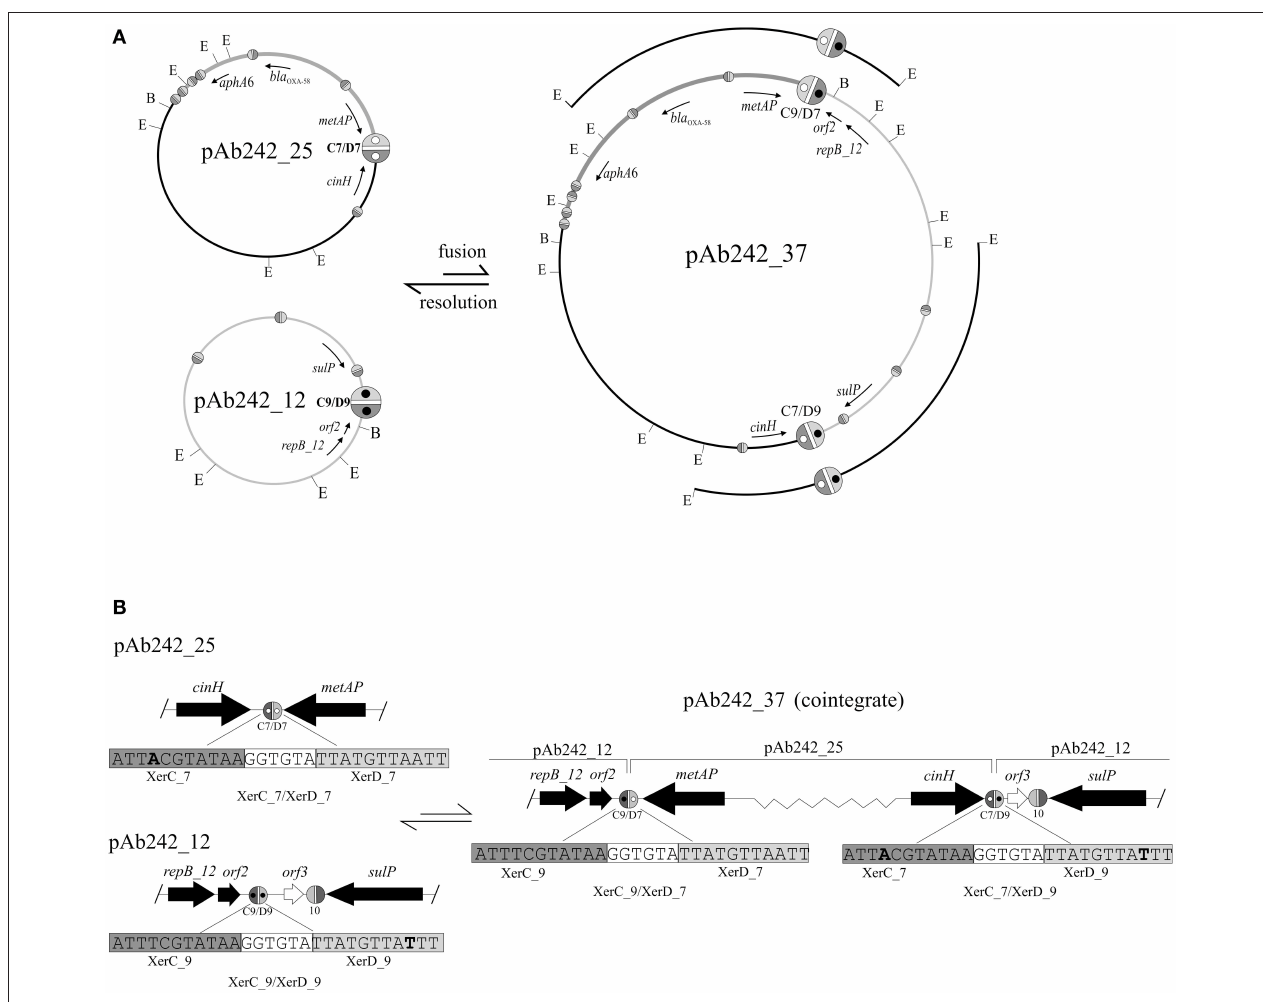
FIGURE 3 | Site-specific recombination between XerC/D sites mediates fusion between pAb242_25 and pAb242_12. ( A , Upper panel) Scheme depicting the formation of the plasmid co-integrate pAb242_37 by inter-molecular site-specific recombination at the sister pair XerC_7/XerD_7 (C7/D7) and XerC_9/XerD_9 (C9/D9) located in pAb242_25 and pAb242_12, respectively. The resolution of pAb242_37 by intra-molecular site-specific recombination at the new pair of XerC/D sites generated during the fusion reaction (C9/D7 and C7/D9, respectively) is also shown. The bla OXA - 58 - and aphA6 -containing adaptive module in pAb242_25 and pAb242_37 is highlighted in dark gray. The positions of EcoRI (E) and BamHI (B) restriction sites in these plasmids are also indicated. The different XerC/D-like recognition sites (see Table 2 for sequence details) are highlighted as ovals (not drawn to scale) as detailed in the legend to Figure 2 . The pair of sites identified as recombinationally active in this work have been arbitrarily enlarged. Open and closed inner circles within XerC_7/XerD_7 and XerC_9/XerD_9, respectively, are shown to facilitate the visualization of the fusions generating XerC_9/XerD_7 (C9/D7) and XerC_7/XerD_9 (C7/D9) in pAb242_37. The cloned EcoRI fragments used to identify these fusions (see text for details) are also indicated above the pAb242_37 scheme. ( B , Lower panel) Enlarged vision including the nucleotide sequences of the XerC/D sites involved in the fusion/resolution reactions showing that the polarity of the sites was maintained after site-specific recombination. Relevant nucleotides in each site are highlighted in bold. Slash (/) symbols at the borders indicate that further sequence data existed beyond this position. The scheme is not drawn to